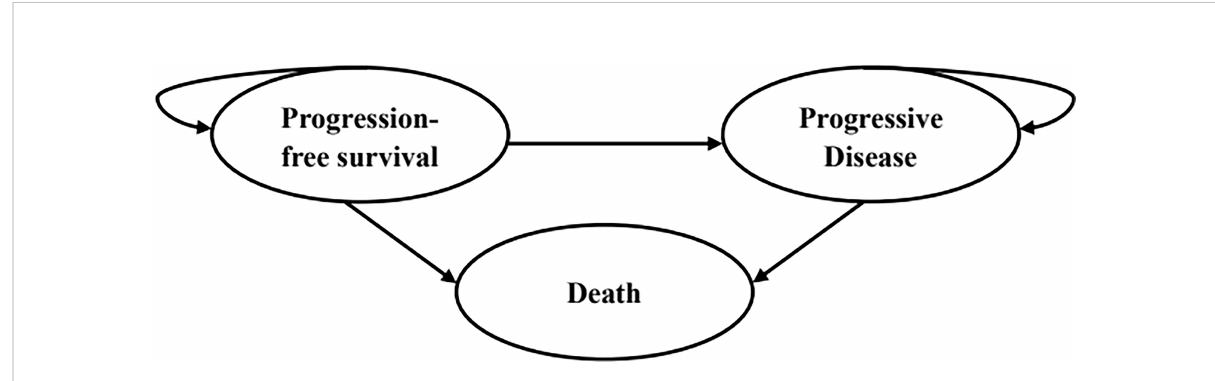
FIGURE 1 The structure of the partitioned survival